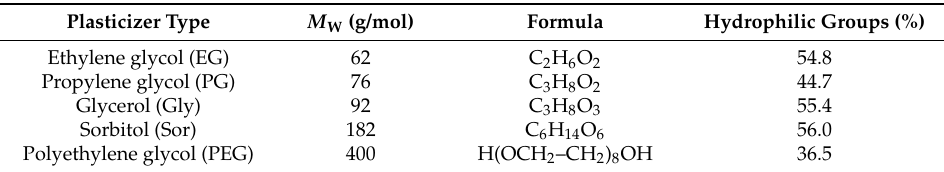
Table 1. Selected plasticizers for study and characteristic